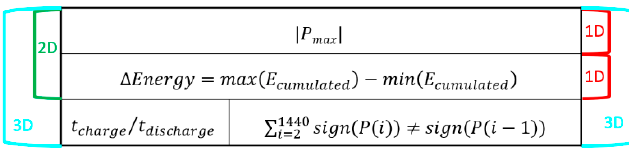
Figure 6. How synthetic indices have been grouped to define clustering features.